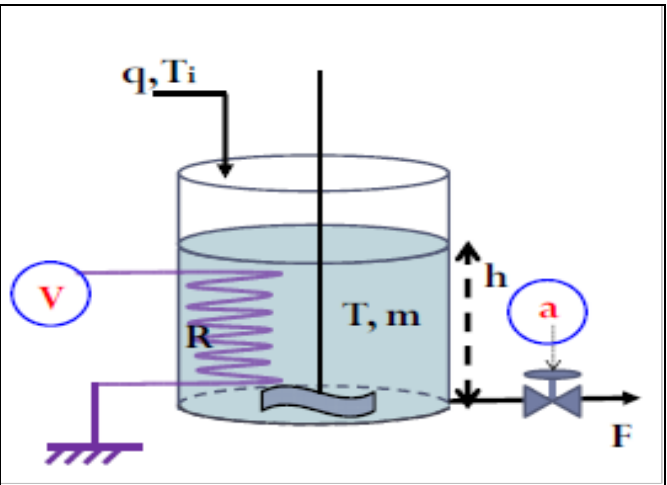
Figure 2: Diagram of the Stirred tank with Heater.